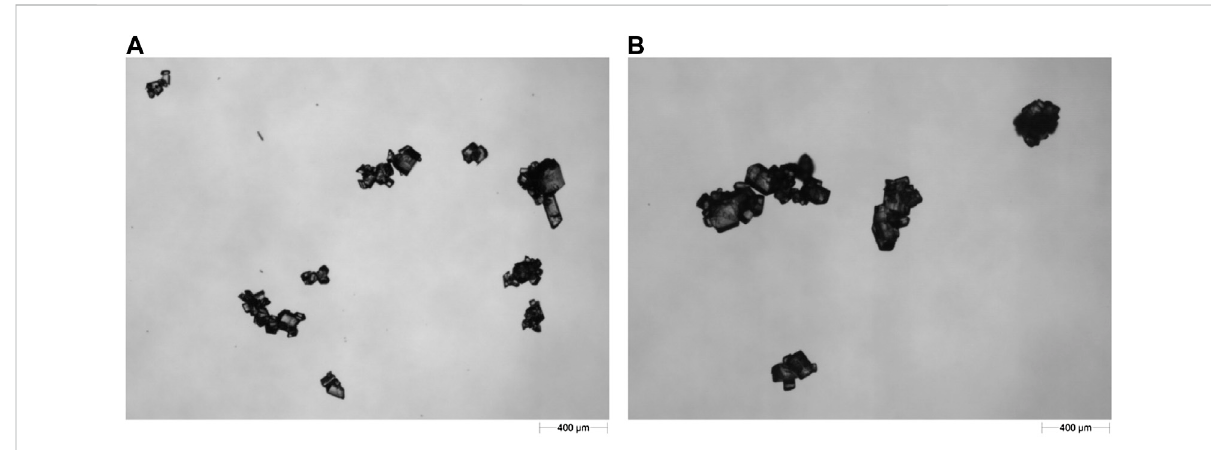
FIGURE 15 Representativemicroscopeimagesofthesamplesfromthepointsof (A) pre-coolingand (B) post-coolinginthecontinuouslypre-mixedsemi- batch